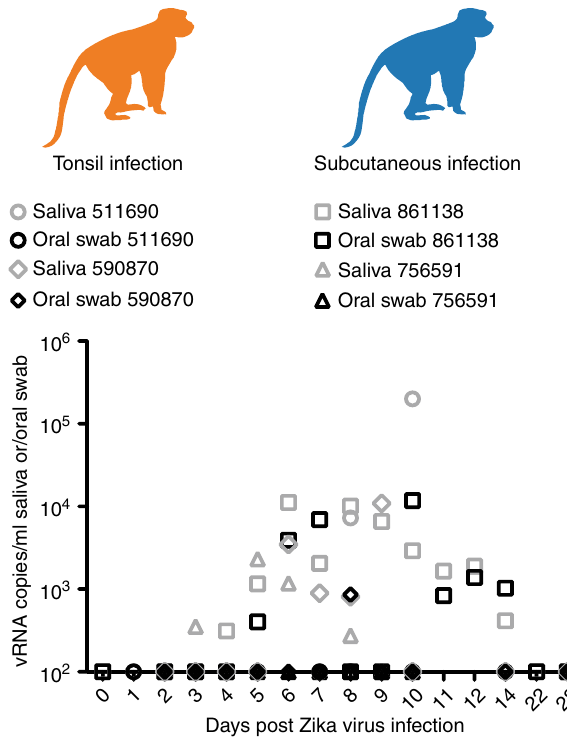
Fig. 3 Longitudinal Zika virus load detected in saliva and oral swabs. Two of three animals infected either via the tonsils (under orange monkey ) or subcutaneously (under blue monkey ) had suf fi cient saliva collected for viral load testing. Only time points in these four animals at which both saliva ( gray ) and oral swabs ( black ) were tested simultaneously are shown. All points not distinguishable above the limit of quanti fi cation (100 vRNA copies per ml) are present on the x